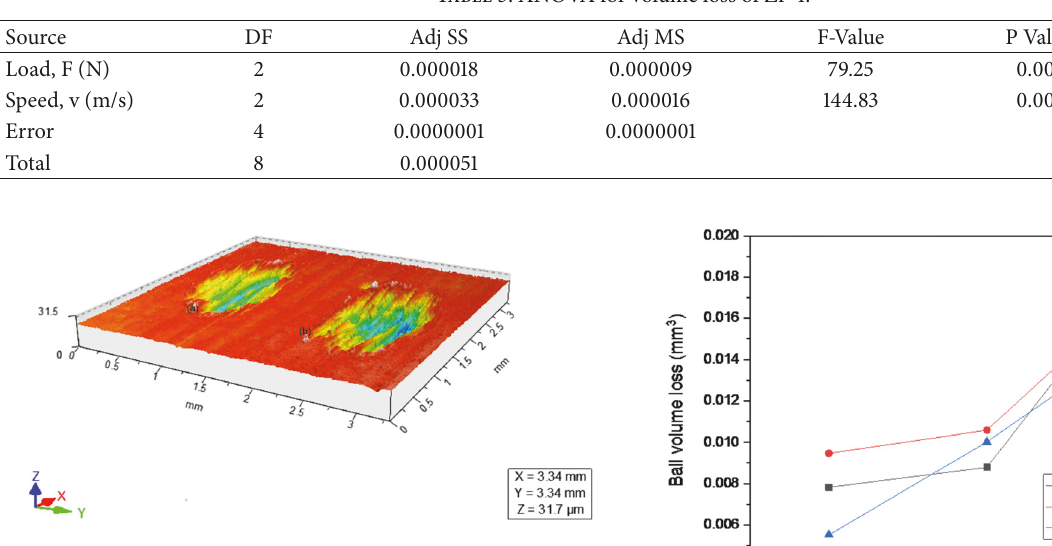
Figure3:3DProfilometryat616MPafor(a)0.020m/sand(b)0.025 m/s sliding speed.